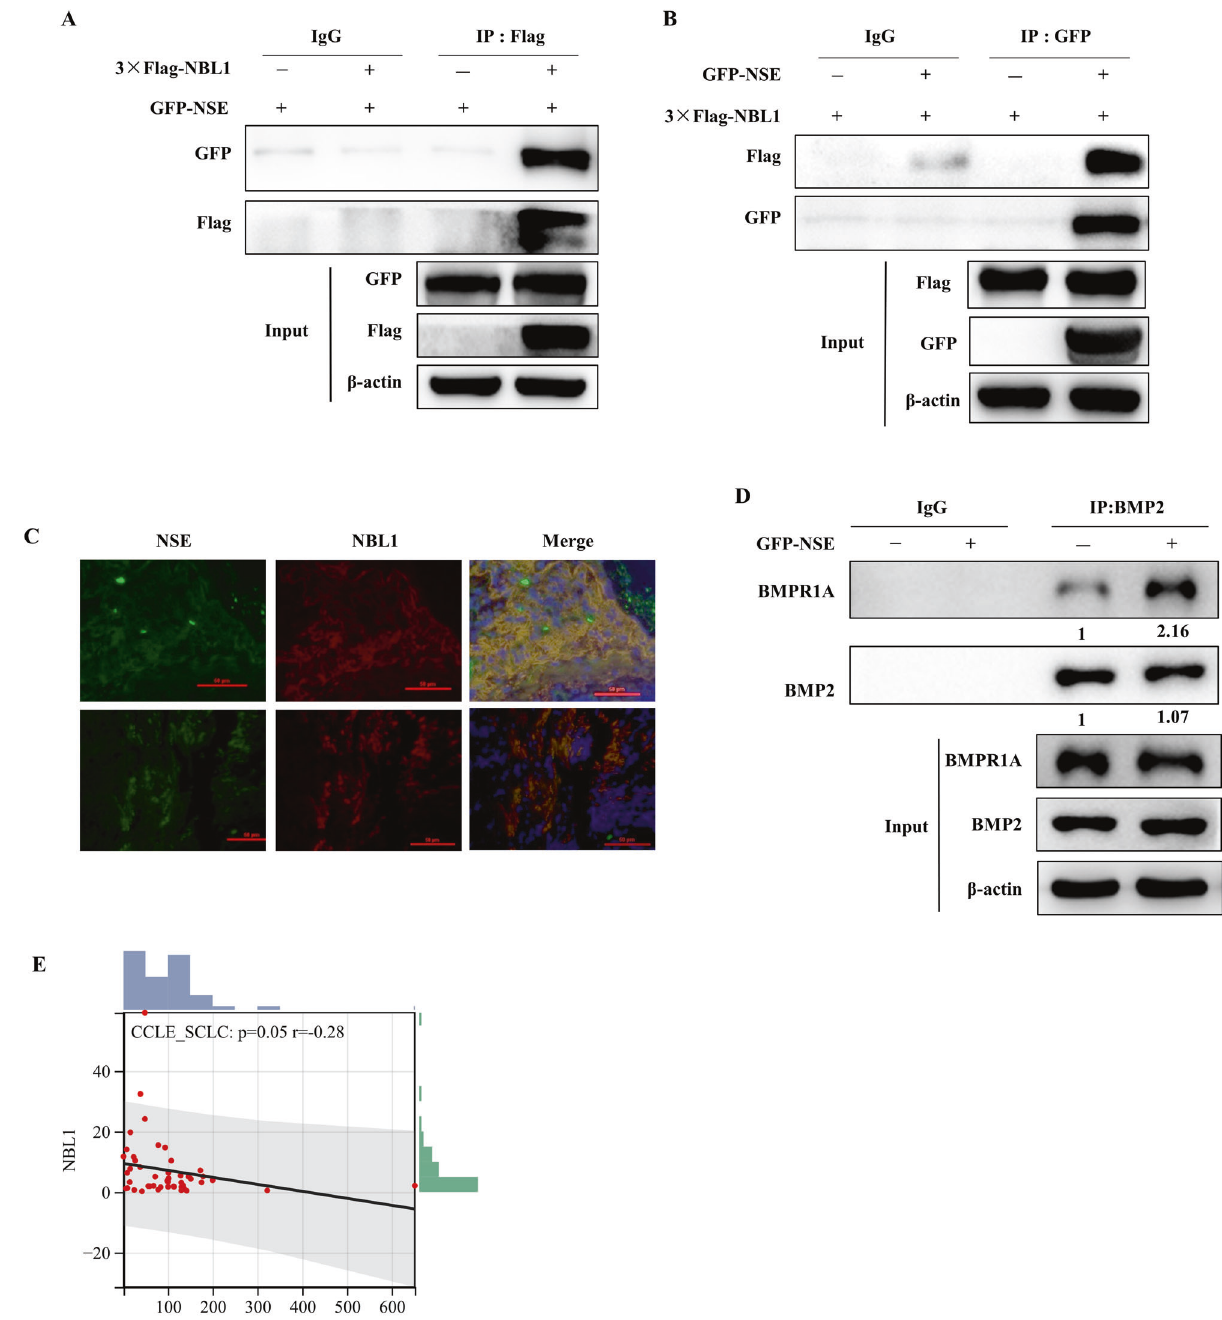
Fig. 5 NSE downregulates and interacts with NBL1 in SCLC cells. A , B Western blot images showed the interaction between NSE and NBL1 by Co-IP experiment. C The double-immuno fl uorescence labeling experiment detected NSE and NBL1 and displayed co-location in clinical samples (original magni fi cation ×40, scale bar 50 μ m). D Western blot images show the interaction of BMP2 and BMPR1A enhanced after overexpression of NSE. E The photo shows a signi fi cant and negative correlation between ENO2 (encode NSE) and NBL1 in mRNA level using the CCLE